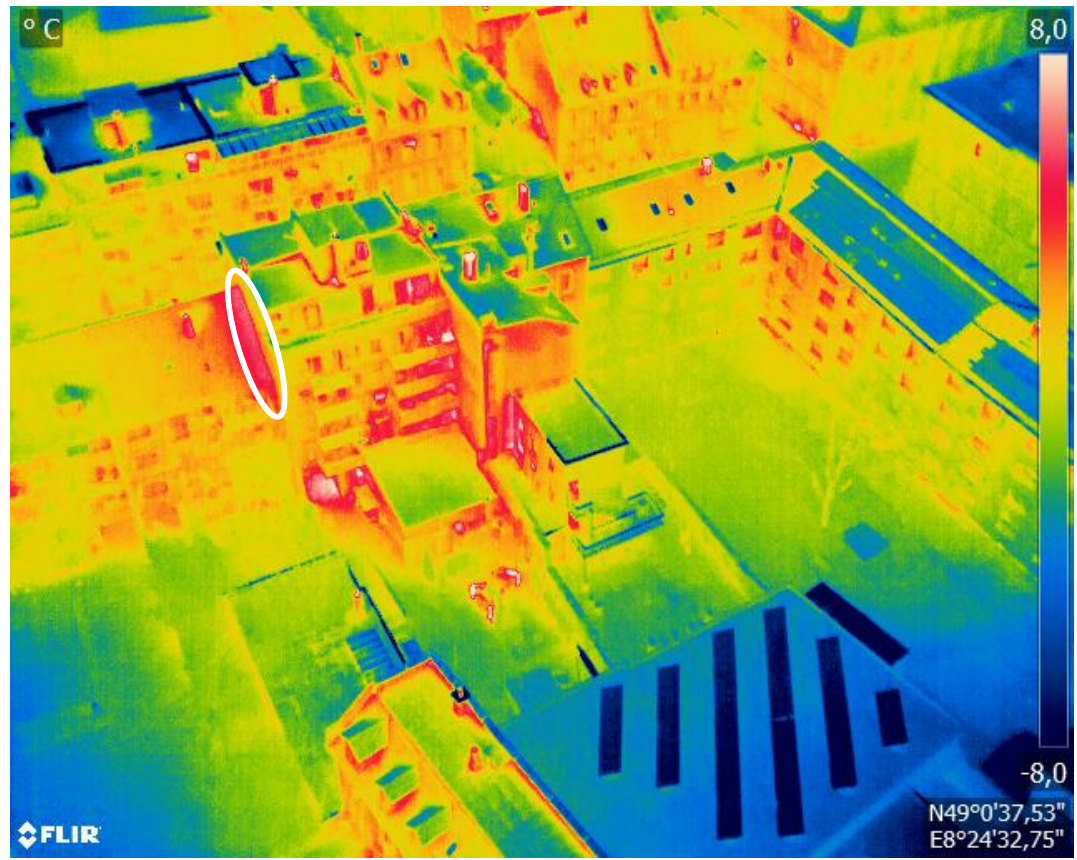
Figure A27. Example: thermal bridge of a connection between a rooftop and a wall.